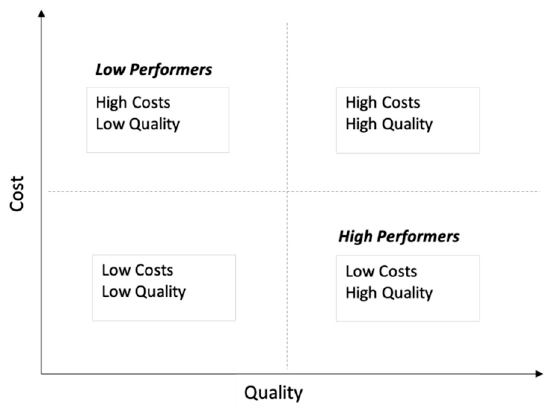
Figure 1. Framework used to evaluate the association between cost and quality hospitals can be classified as high or low performers based on their costs and quality of care.